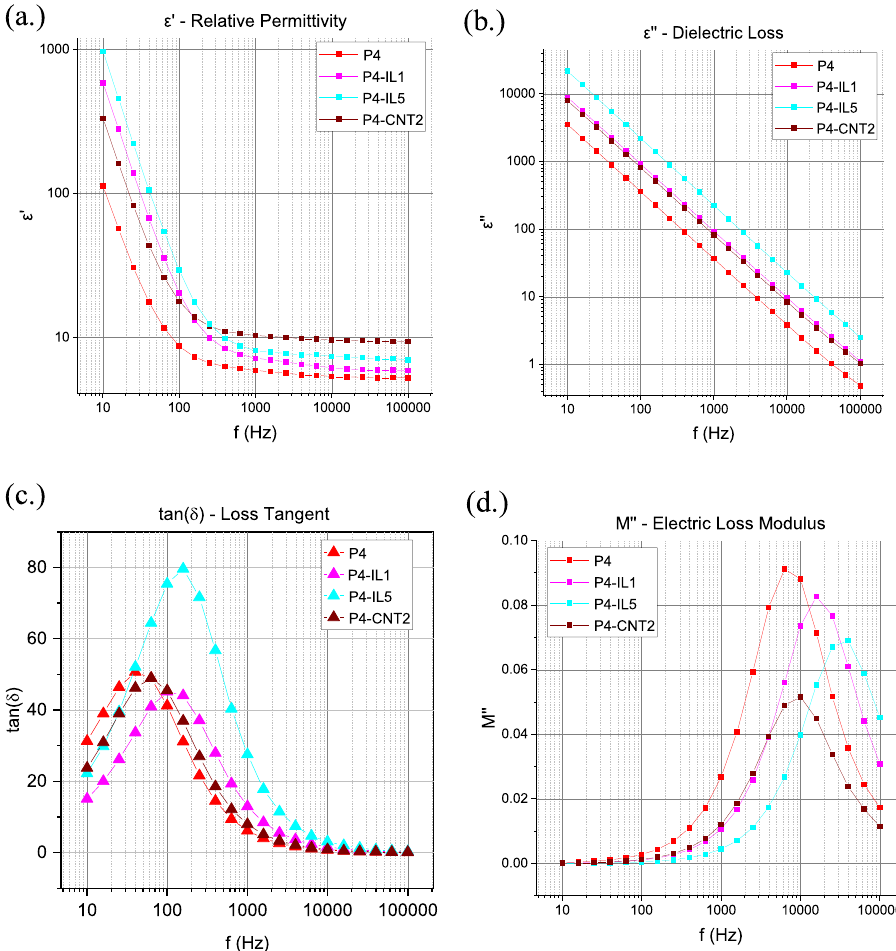
Figure 3. ( a ) Relative permittivity, ( b ) dielectric loss, ( c ) loss tangent comparison, ( d ) electric loss modulus M ″ versus frequency comparison for different conductive